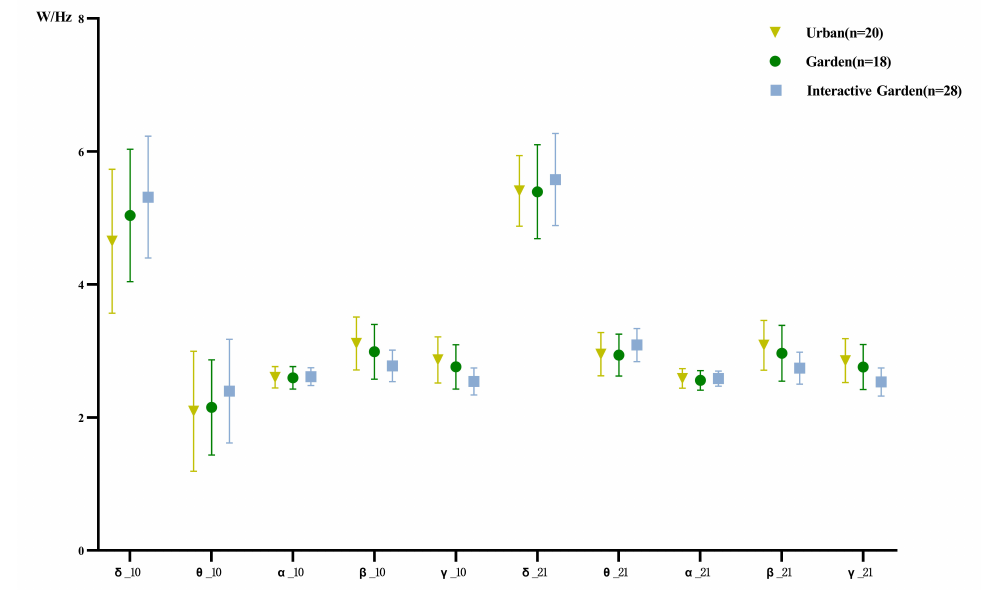
Figure 12. Descriptive statistical results of the change of PSD in different frequency bands.